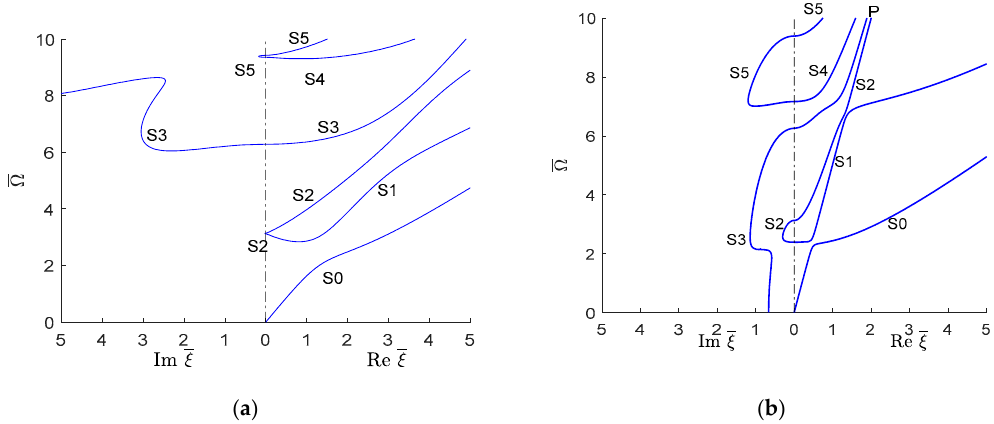
Figure 15. Real (propagating) and imaginary (evanescent) wavenumber solution of symmetric Lamb wave type GWs for ( a ) isotropic aluminum alloy; ( b ) unidirectional CFRP composite.